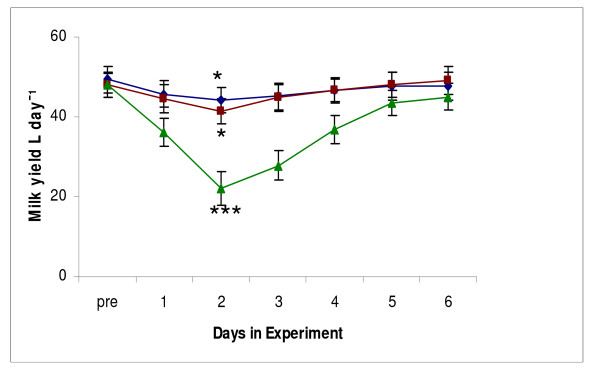
Effect of treatments on milk yield and its post-treatment recovery. (diamonds, treatment C; squares, treatment D; triangles, treatment E; * P < 0.05 in comparison with pretreatment values; *** P < 0.001 in comparison with pretreatment values and treatments C and D).